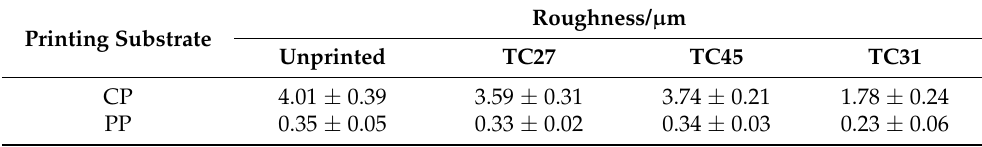
Table 2. The roughness of unprinted and printed